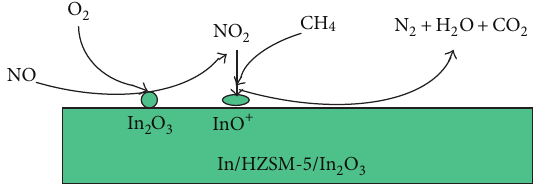
Figure 13: Schematic diagram for NO reduction by methane over In/HZSM-5/In 2 O 3